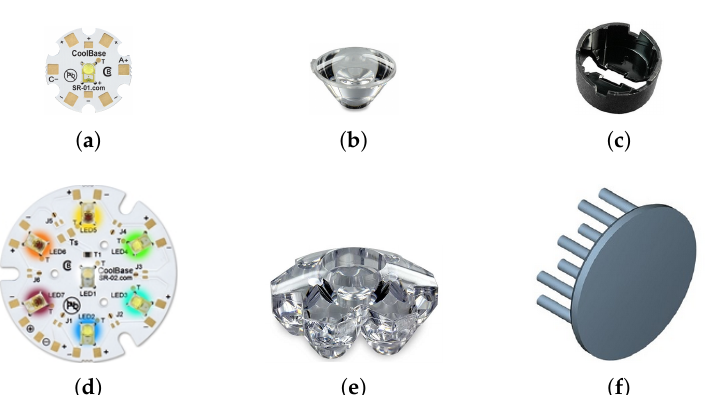
Figure 5. Components of the two optical configurations of multispectral light source: ( a ) single LED assembly; ( b ) fiber coupler concentrator lens; ( c ) circular lens holder; ( d ) seven-LED array assembly; ( e ) multi-cell cluster concentrator optic; and ( f ) natural convection heat sink.